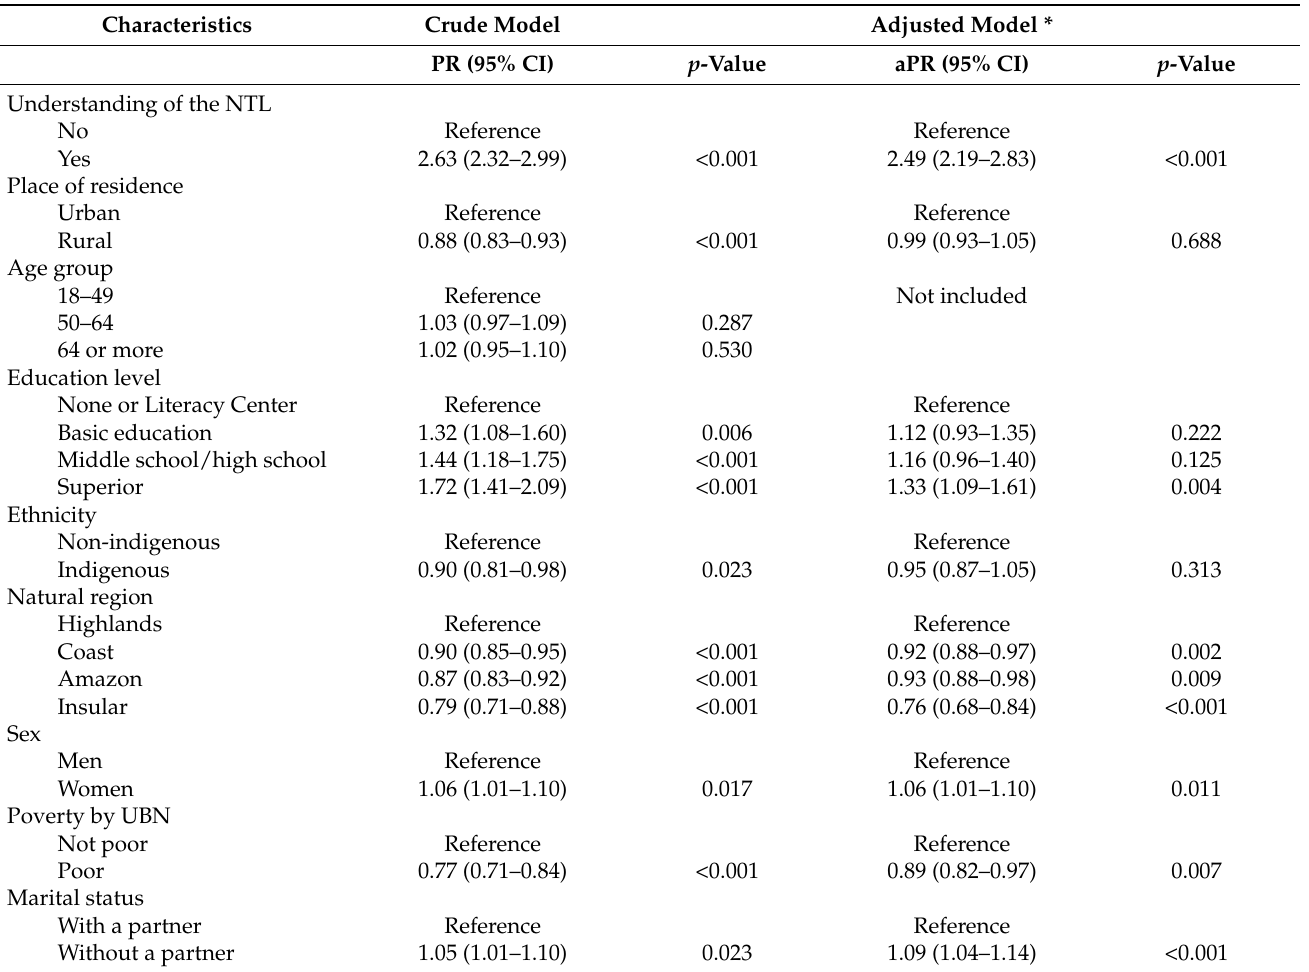
Table 3. Factors associated with the influence of food traffic light labeling on the decision to purchase processed foods in the adult population of Ecuador,